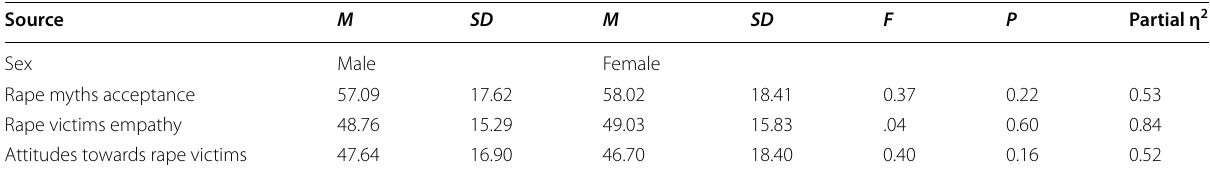
Table 4 Mean differences with regard to rape-related attitudes, rape myths acceptance and its subscales, and subscales of causal attributions of sexual violence scale